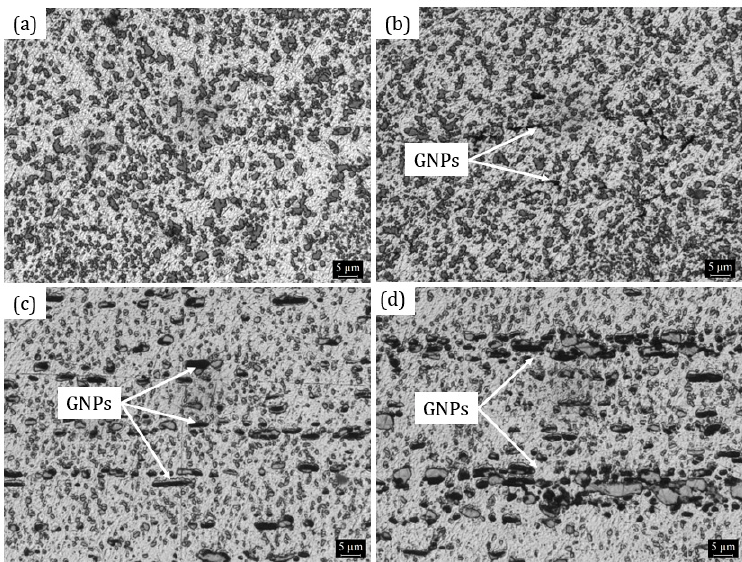
Figure 4. Light micrographs of ( a ) AlSi10Mg, ( b ) AlSi10Mg–0.5 wt.% GNPs, ( c ) AlSi10Mg–1 wt.% and ( d ) AlSi10Mg–2 wt.% GNPs after hot consolidation parallel to the compaction direction.